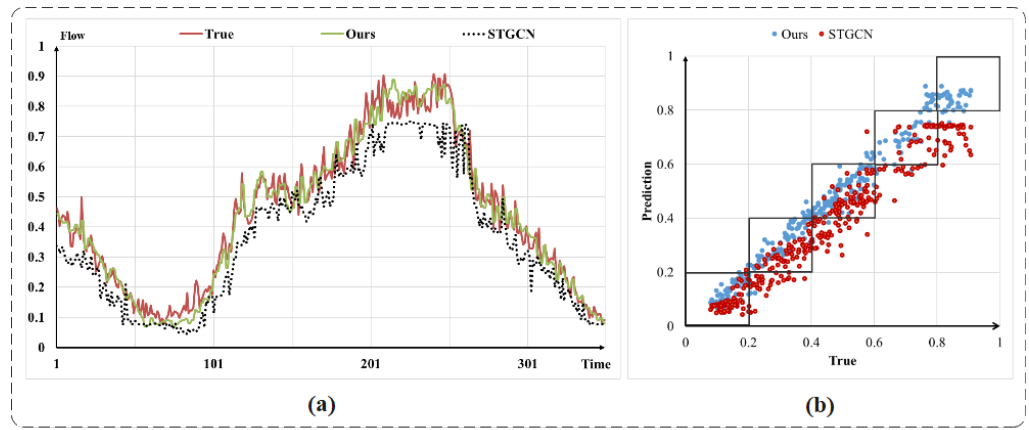
Figure 10. Comparison of DSGCN and STGCN prediction results. ( a ) is a time-series variation plot. ( b ) is a numerical scatter plot. ( b ) is a numerical scatter